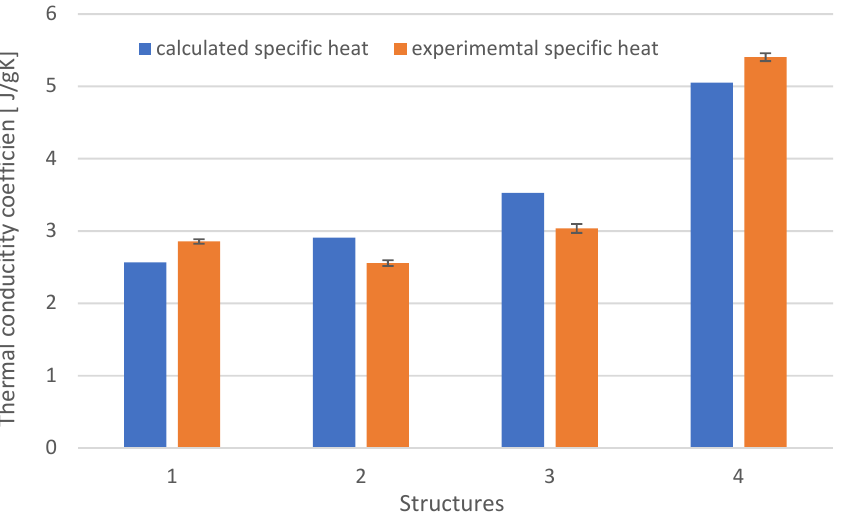
Figure 9. Thermal diffusivity for different composite structures. The determined thermal characteristics were used to determine the thermal conduc- tivity coefficient. Results are shown in Figure 10.